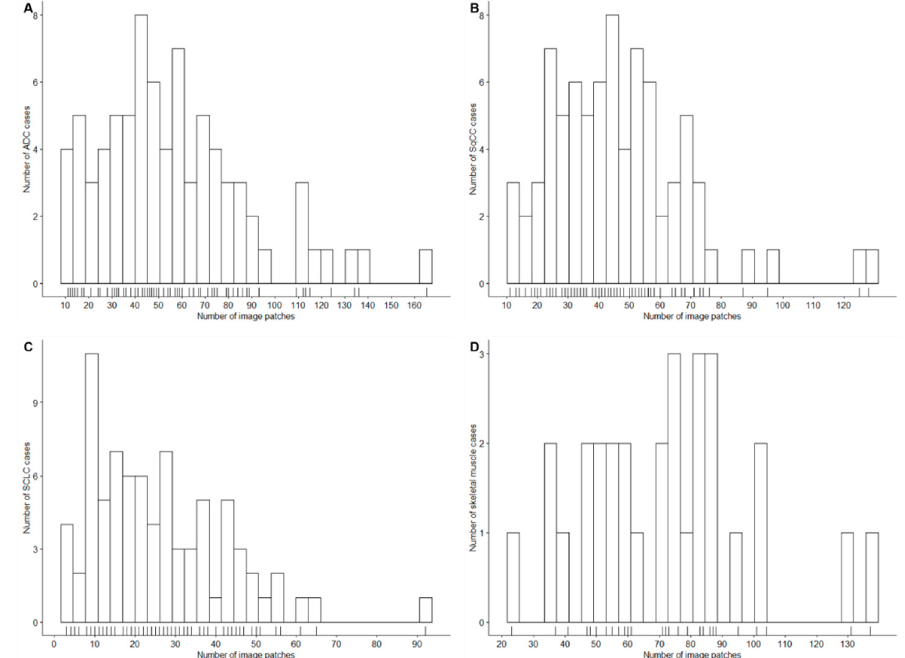
Figure 3. Number of patches according to the tissue type. The histograms show the number of annotated image patches for ADC ( A ), SqCC ( B ), SCLC ( C ), and skeletal muscle ( D ) Table 1. Descriptive statistics of annotated image patches and analysis subsets.